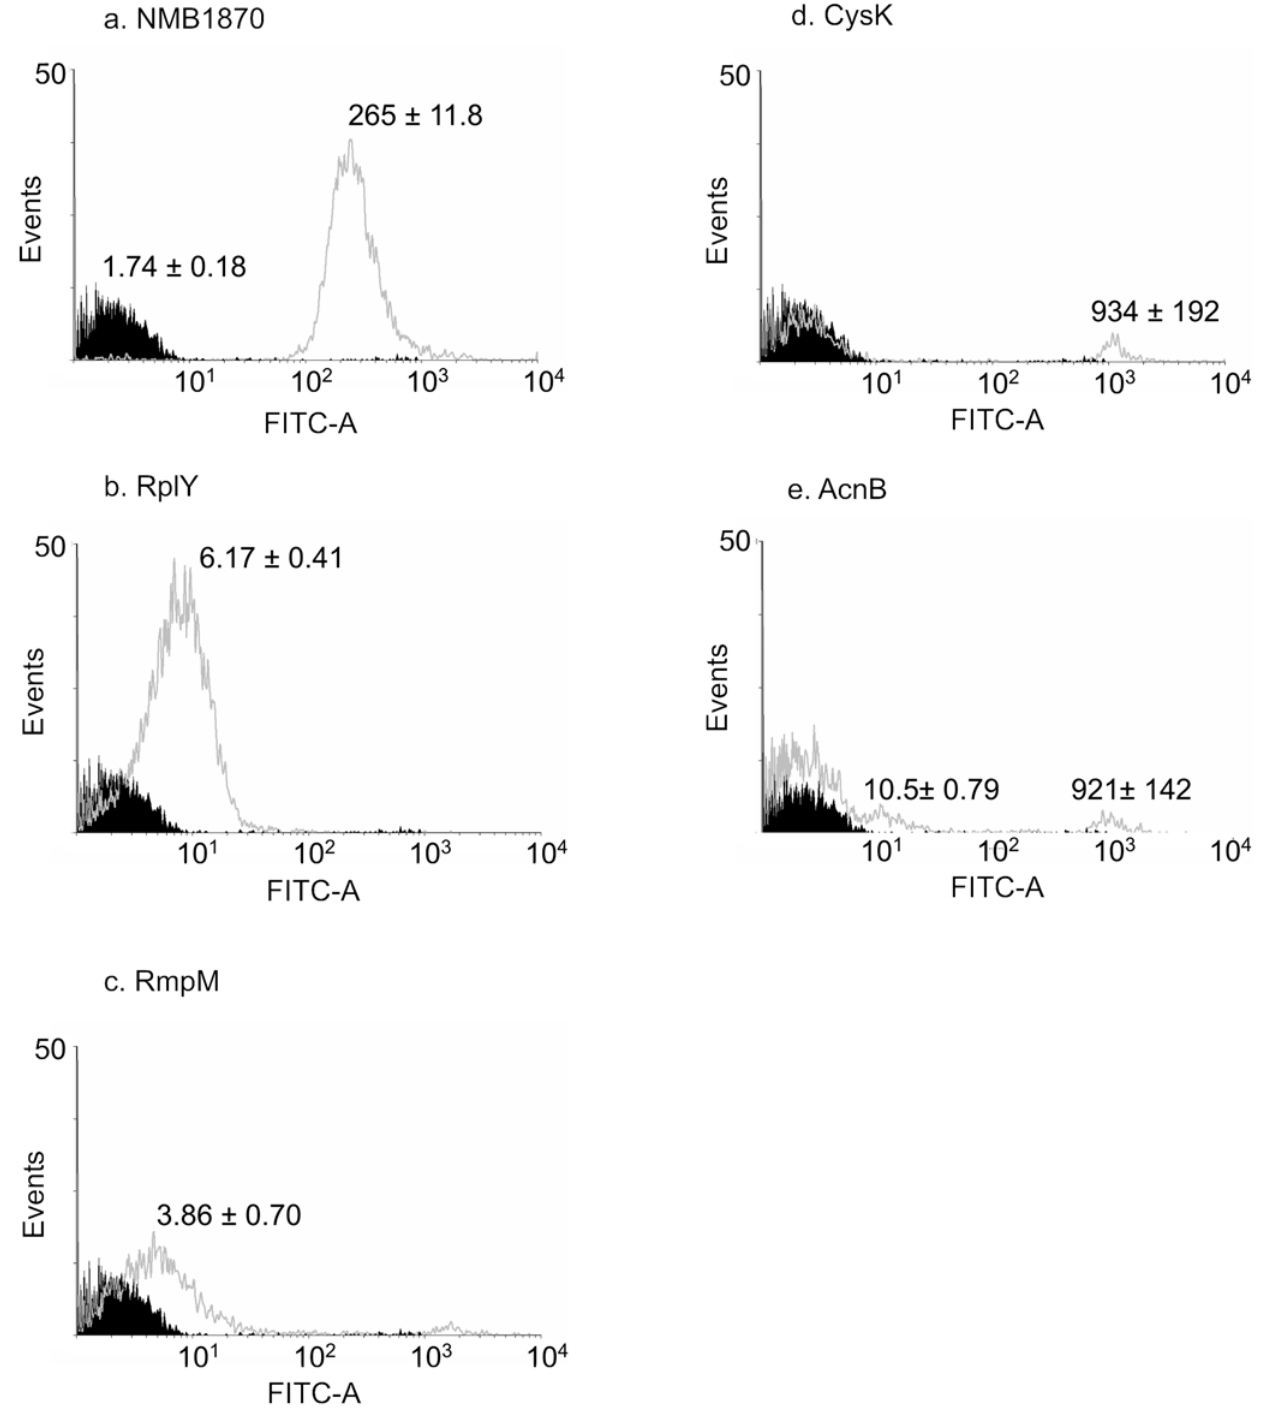
Figure 3. Flow cytometry of live N.meningitidis stained with mouse sera immunised with recombinant proteins. Flow cytometry data for live N. meningitidis cells stained with sera from mice immunised with PBS alone (black) or with recombinant proteins (grey), fHBP has been used as a positive control (Fig 3a). Values are means of fluorescence with standard deviations derived from triplicate experiments.